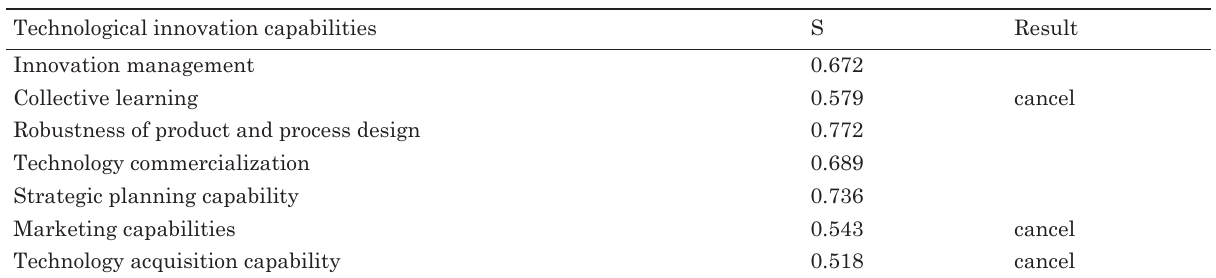
Table 4. Final criteria for technological innovation